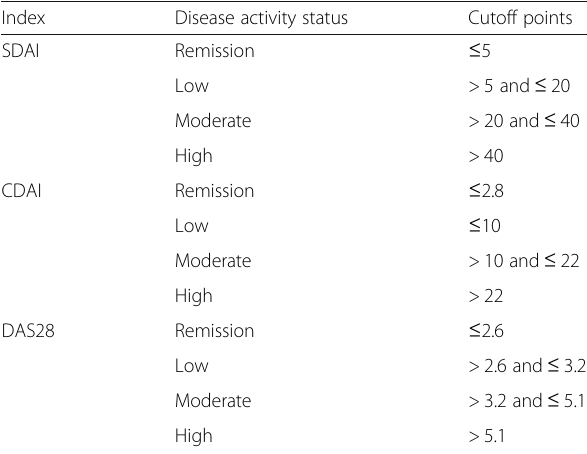
Table 5 Definition of the status of activity of rheumatoid arthritis and respective cutoff points using composite disease activity indices